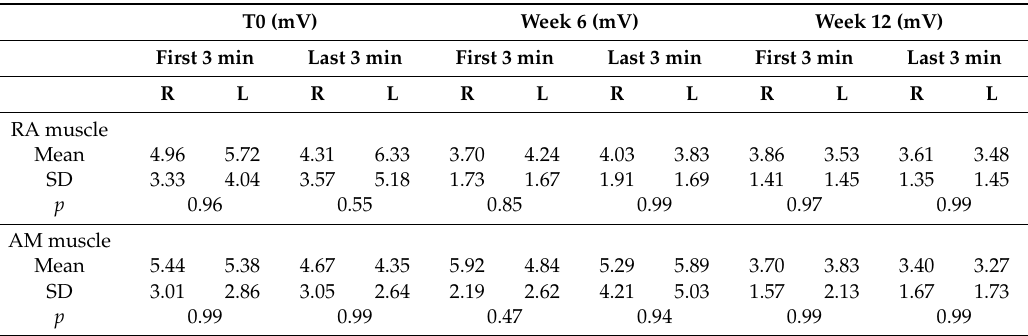
Table 4. Comparison of mRMS values (in mV) for the RA and AM muscles with respect to the side (R: right, L: left), depending of the time of recording (first 3 min and last 3 min of the session) and the time of treatment (initial session, at week 6, and at week 12). Tukey multiple-comparison post-test p -values are